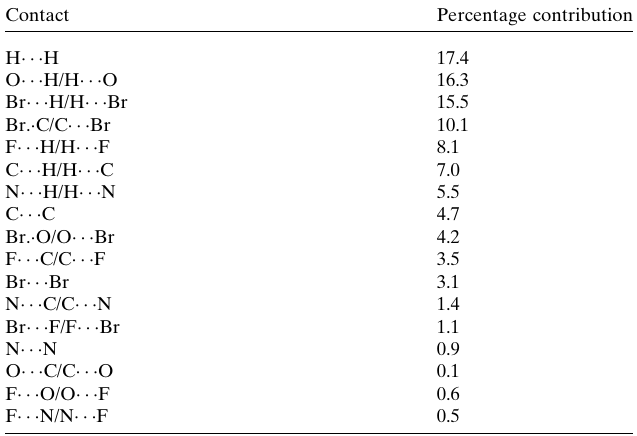
Table 2 Summary of short interatomic contacts (A˚ ) in the title salt. Contact